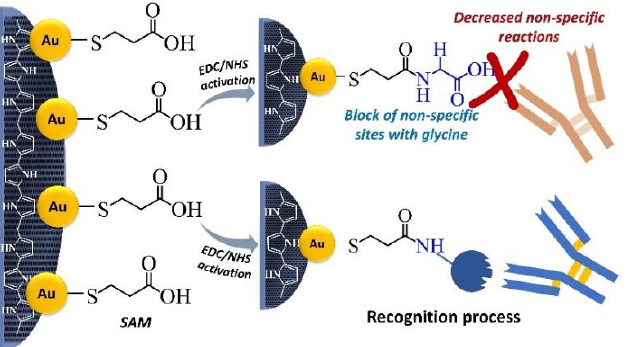
Figure 1. The SAM formation is due to the covalent interaction between gold and sulfur, which makes possible biomolecule immobilization through the carboxylic groups.